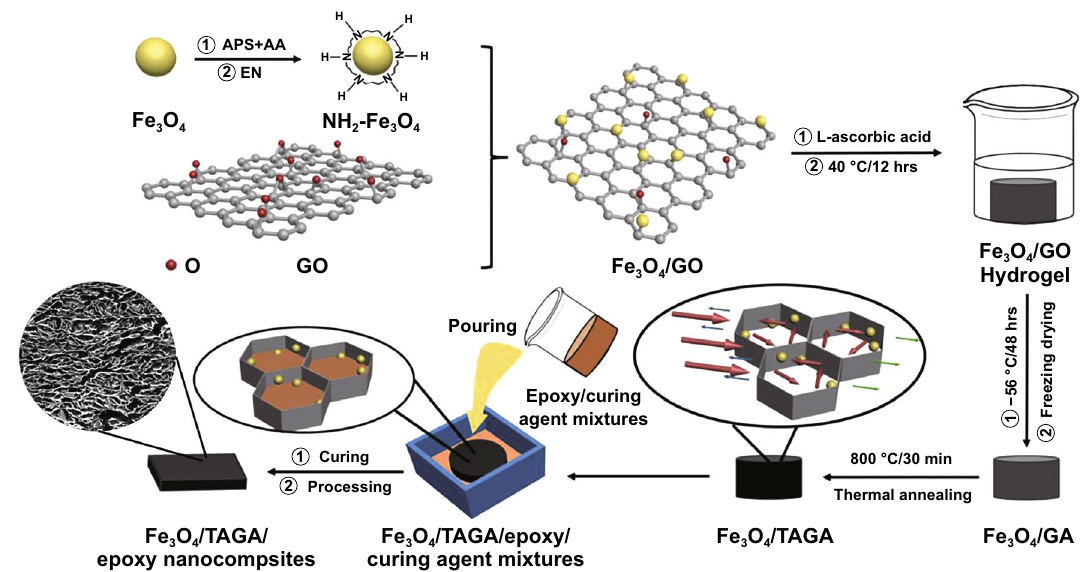
Fig. 5 Schematic diagram of the fabrication for Fe 3 O 4 / thermally annealed graphene aerogel (TAGA)/epoxy nanocomposites by pour casting. Reprinted with permission from Ref. [104]